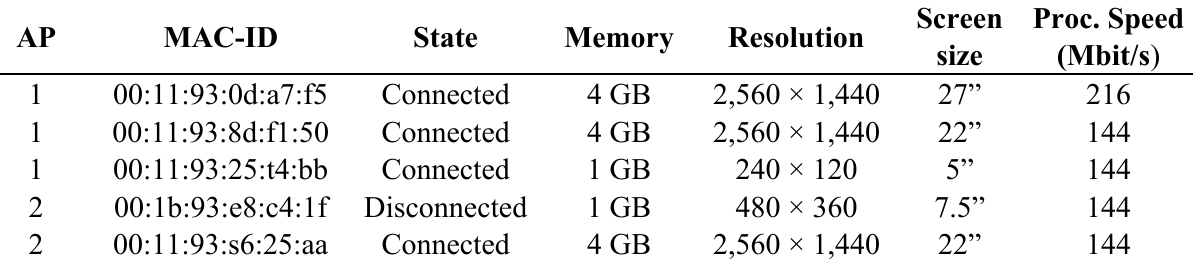
Table 2. Context model of physical situation.